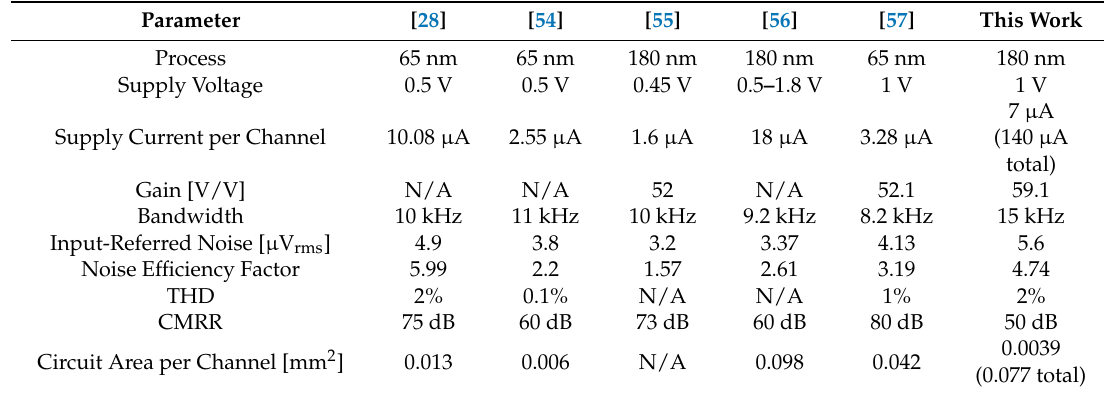
Table 2. Measured performance of the rapidly multiplexed CMOS design ( M = 20) and comparison to state-of-the-art neural recording